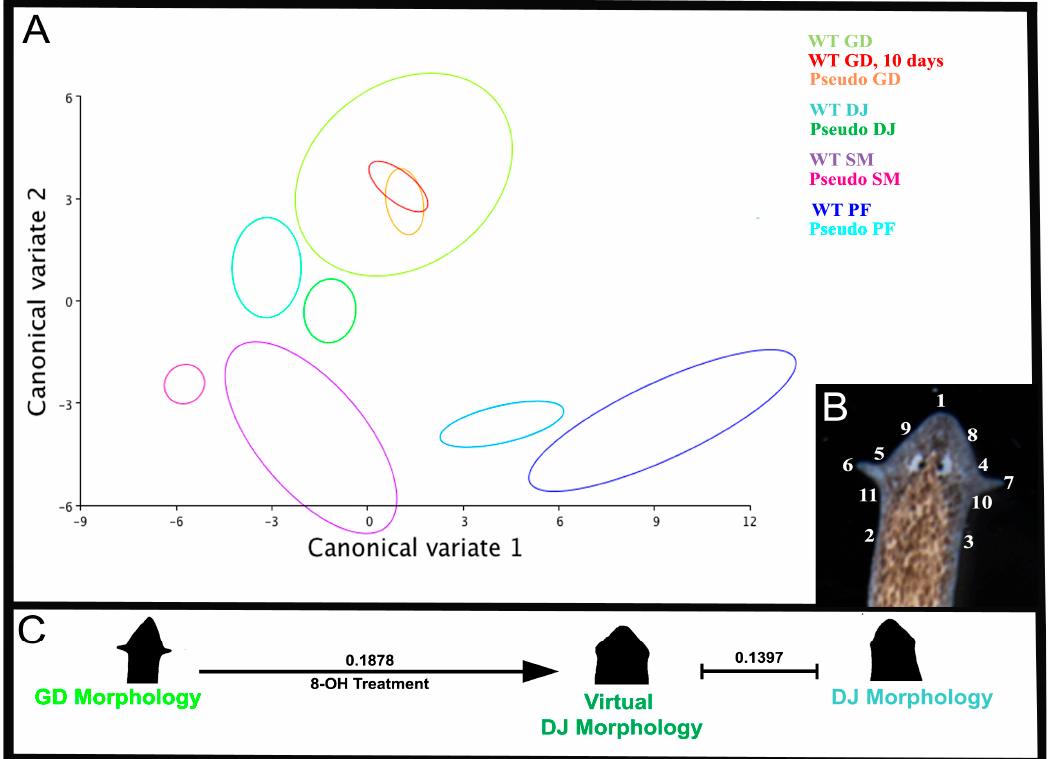
Figure 2. Canonical variate analysis of head shape. ( A ) Graphical output, showing confidence ellipses for means, at a 0.9 probability, of shape data from wild-type and experimentally derived morphologies. Ellipses are colored to correspond with phenotype and treatment. n = 10 WT G. dorotocephala , n = 8 WT G. dorotocephala 10 days after amputation and regenerated in water, n = 9 WT D. japonica , n = 6 WT P. felina , n = 8 WT S. mediterranea , n = 7 pseudo G. dorotocephala , n = 13 pseudo D. japonica , n = 5 pseudo P. felina , and n = 6 S. mediterranea flatworms were measured; ( B ) Legend of